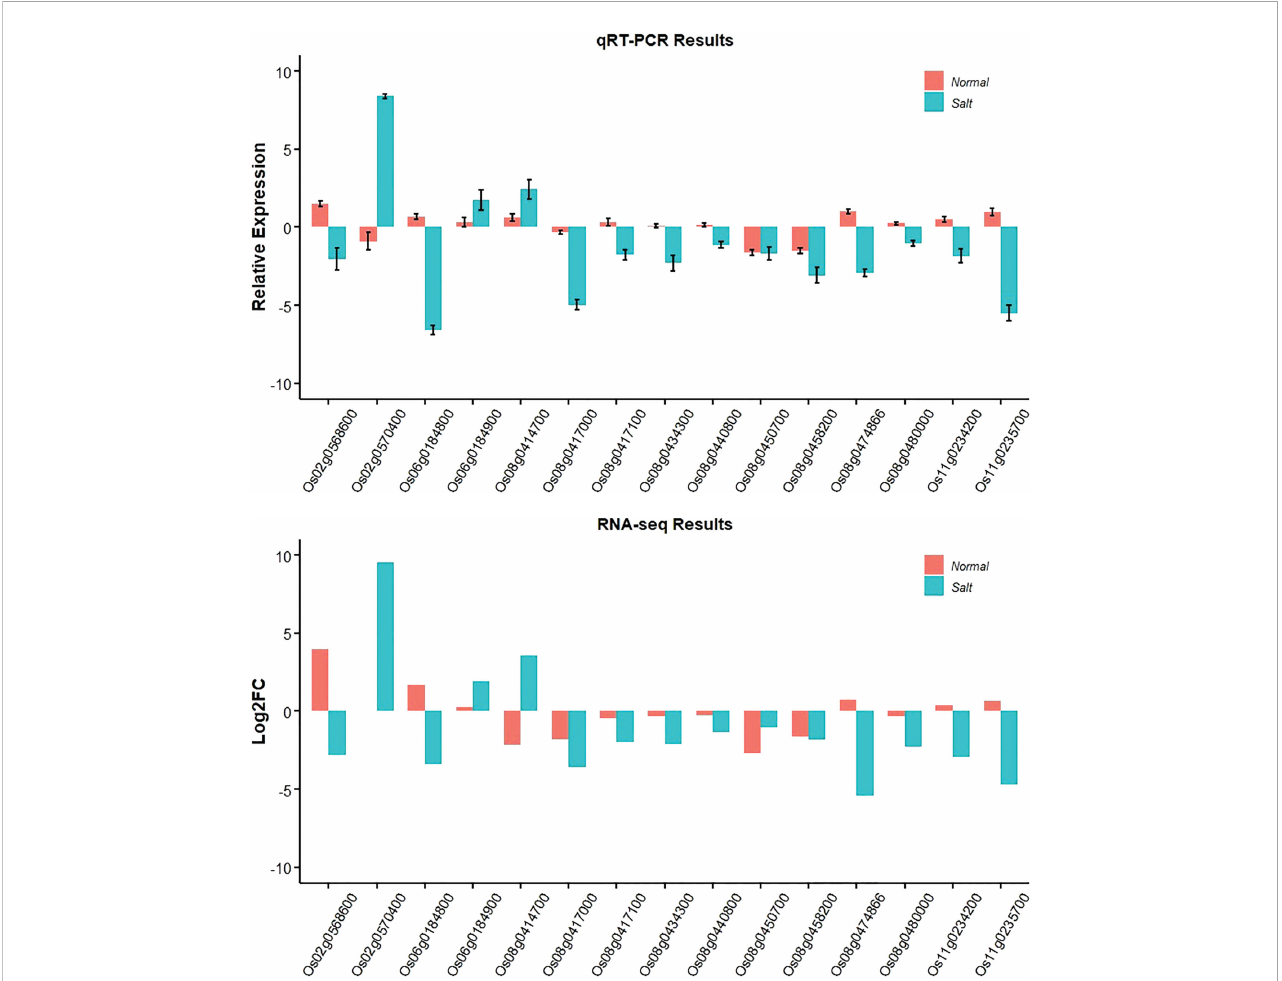
FIGURE 7 Gene expression changes under salt stress and normal conditions based on qRT-PCR and